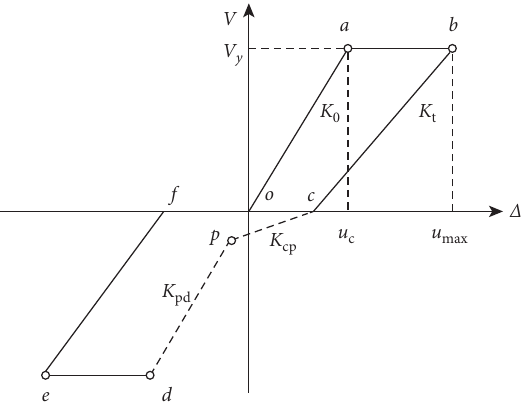
Figure 2: Steel shear wall pinching hysteresis